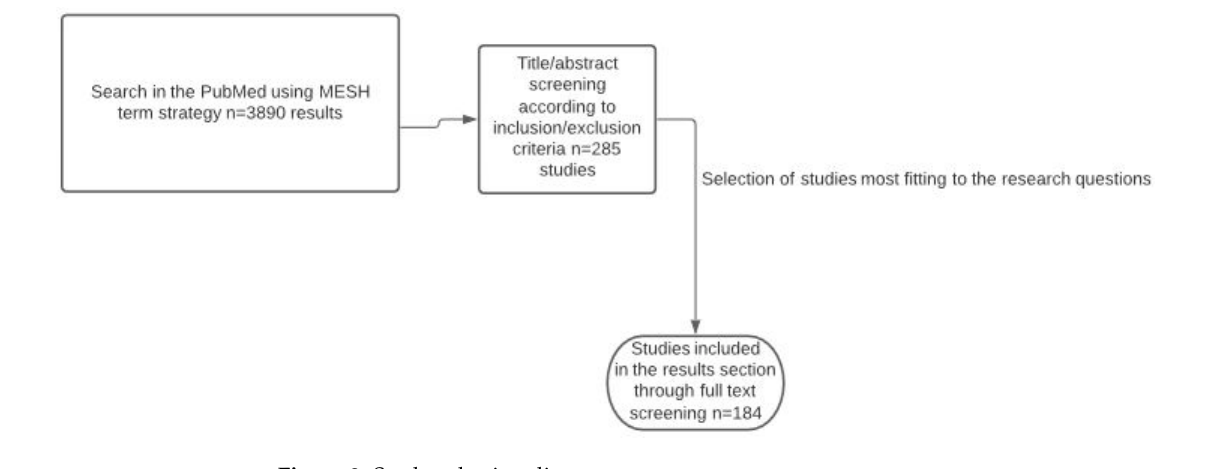
Figure 3. Study selection diagram.